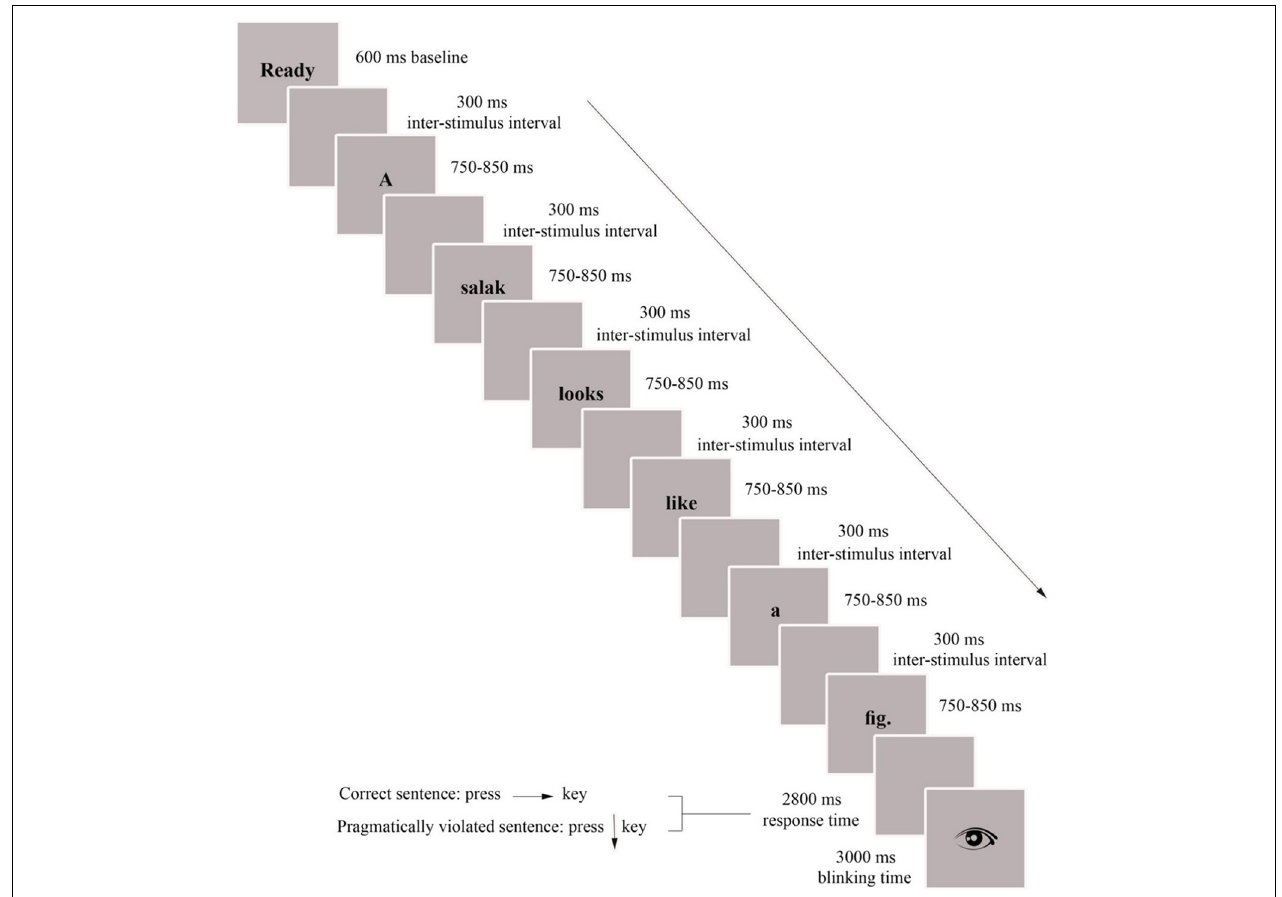
FIGURE 3 | Screen simulations and temporal sequence of an experimental block of the sentence acceptability judgment